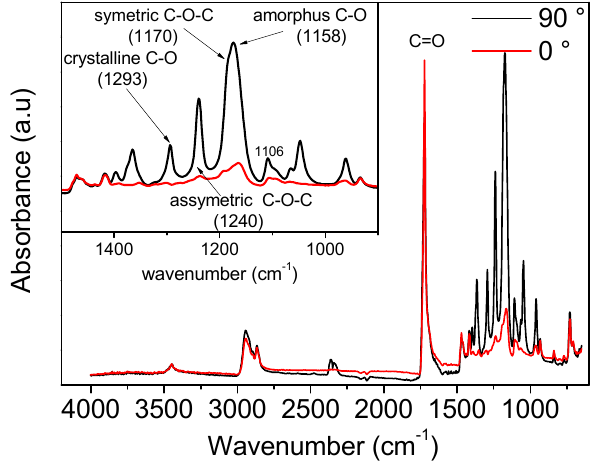
Figure A1. Example of FTIR spectra measured for PCL. The black line corresponds to measurements performed with the polarizers at 90°, while the red line corresponds to measurements performed with the polarizers at 0°.